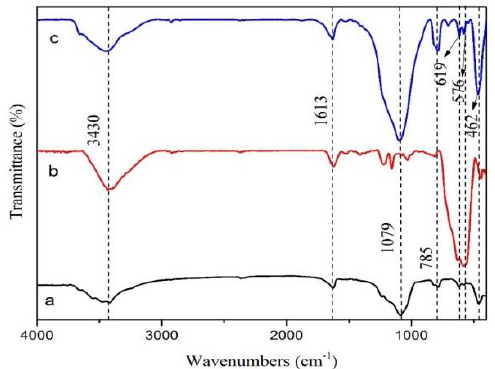
Figure 2. FTIR patterns of ( a ) MAG, ( b ) Fe 3 O 4 , and ( c ) MAG–Fe 3 O 4 .